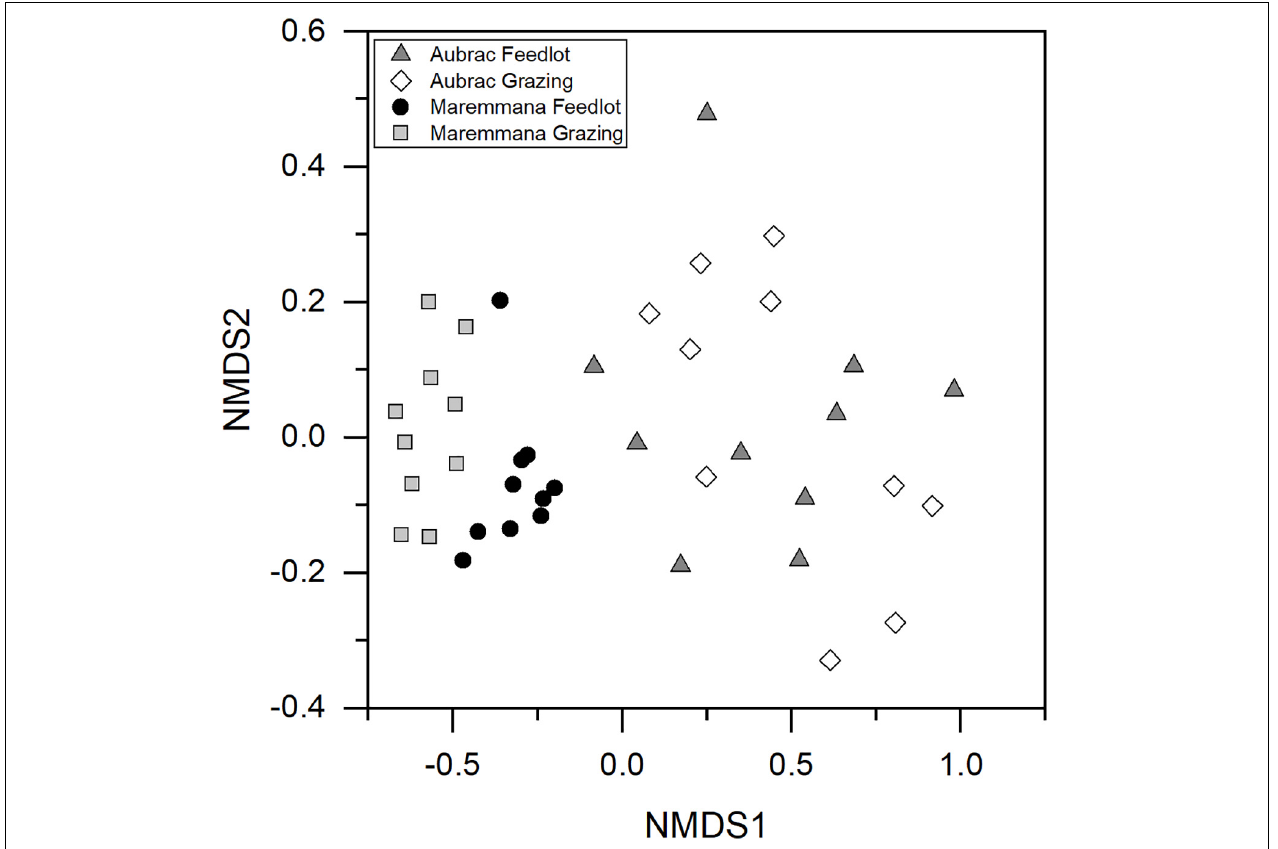
FIGURE 2 | Non-metric multidimensional scaling plot based on Hellinger transformed OTU abundance data. The bacterial communities selected in the rumen of the two breeds reared in different conditions are